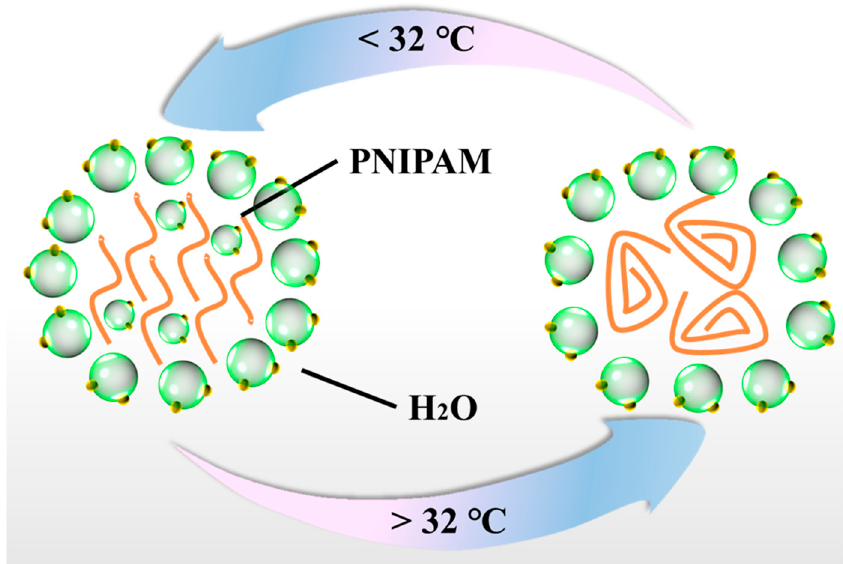
Figure 1. Scheme of phase transition behavior of PNIPAM.